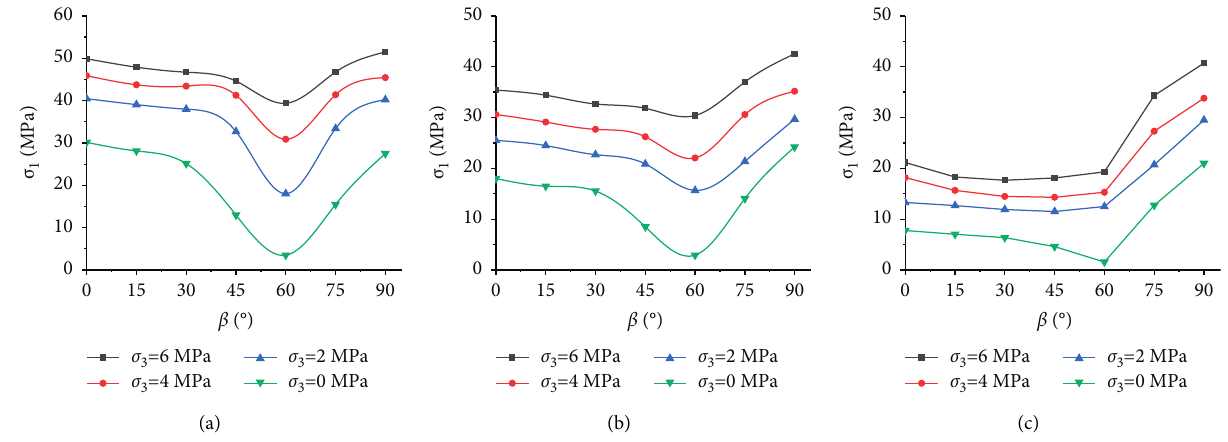
Figure 9: Effect of the bedding plane inclination on peak strength: (a) Group AA, (b) Group AB, and (c) Group AC.